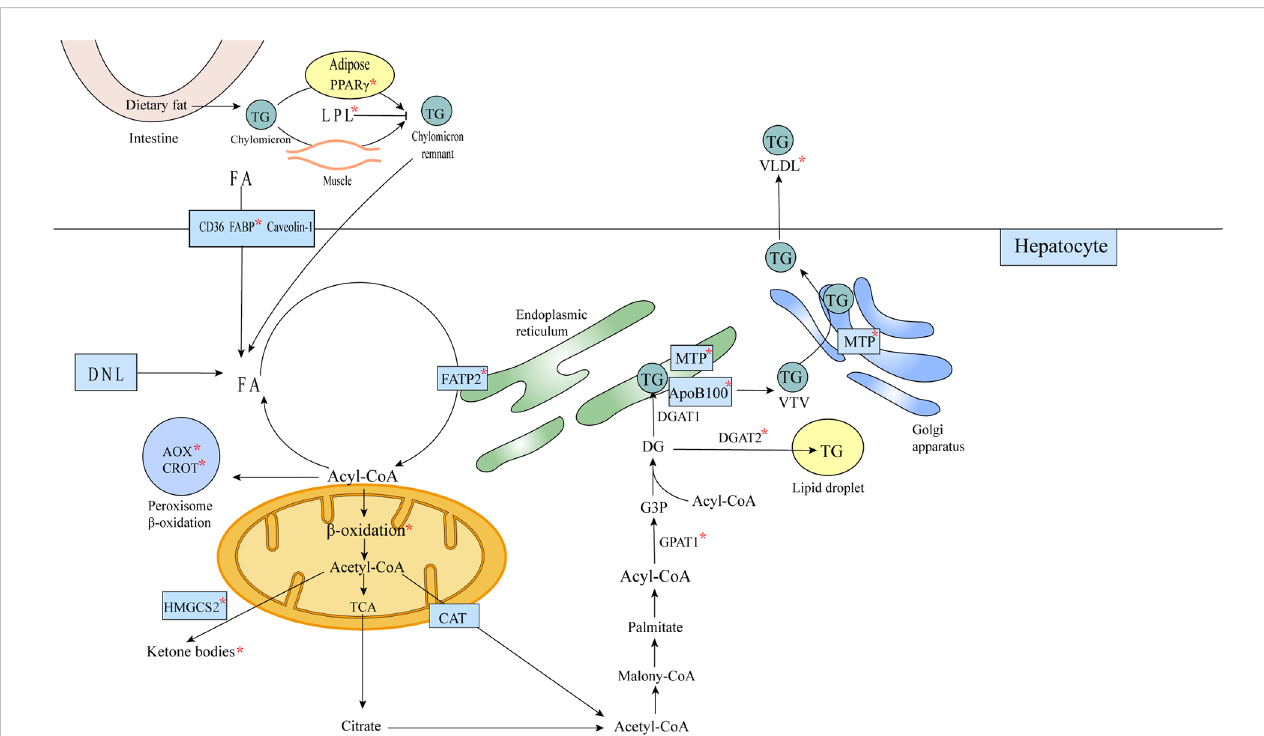
FIGURE 5 FOXA affects lipid metabolism in hepatocytes. Triglycerides remaining in the chylomicron remnants are transported to the liver as a source of FA in hepatocytes, and FA translocase (FAT)/CD36, plasma membrane FA-binding protein (FABP) and Caveolin-1 mediate the uptake of fatty acids bound to circulating albumin, or the acquisition of FA through de novo lipogenesis (DNL). Acetyl coenzyme A is converted to citric acid, ketone bodies or to carnitine/acetyl coenzyme A (CAT), from the mitochondria into the cytosol (57). In the cytosol, acetyl coenzyme A is used for the synthesis of triglycerides and very low density lipoproteins. Triglycerides can be stored in intracellular lipid droplets or packaged into very low density lipoproteins and secreted into the plasma. The formation of mature VLDL requires two lipidation processes mediated by MTP (58).The metabolic processes or substances involved in metabolism affected by FOXA are marked with an asterisk in the fi